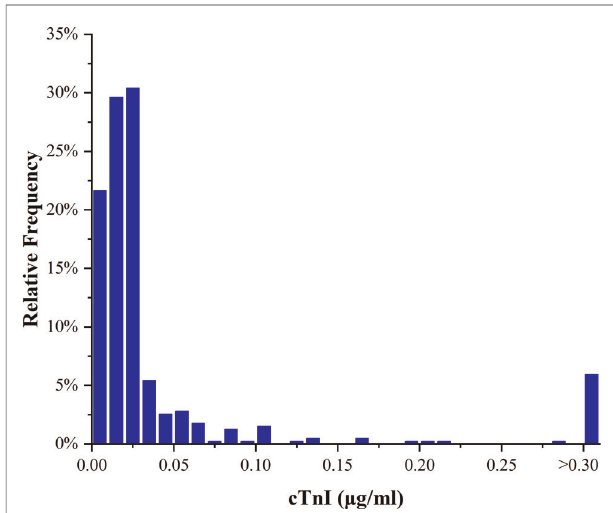
FIGURE 1 | Frequency distribution histogram of cTnI in the study population ( n =403). cTnI, cardiac troponin I.